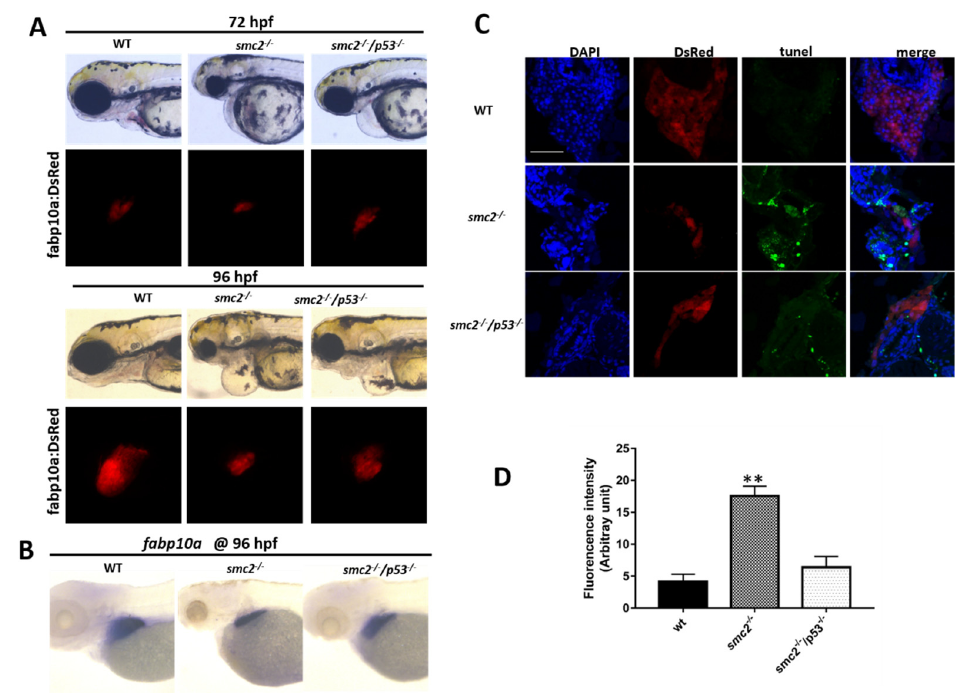
Figure 6 . Activation of the p53-dependent apoptotic pathway contributed to the small liver pheno- type in SMC2 − / − mutants. ( A ) Phenotype comparison of WT, SMC2 − / − and SMC2 − / − /p53 − / − em- bryos under the Tg (fabp10a:dsRed;ela3l:EGFP) transgenic background at 72 hpf and 96 hpf. ( B ) WT em- bryos, SMC2 − / − and SMC2 − / − /p53 − / − embryos stained with the fabp10a probe at 96 hpf. ( C ) TUNEL analysis of apoptotic cells in the liver of SMC2 − / − /p53 − / − mutants compared to WT and SMC2 − / − mu- tants at 96 hpf under the Tg (fabp10a:dsRed;ela3l:EGFP) transgenic background. Scale bar, 50 μ m. ( D ) Quantitative analysis of the apoptotic cells in the liver. Fluorescence intensities of three WT em- bryos, three SMC2 − / − mutant embryos and three SMC2 − / − /p53 − / − embryo across the liver were deter- mined using the ImageJ software. **, p < 0.01.